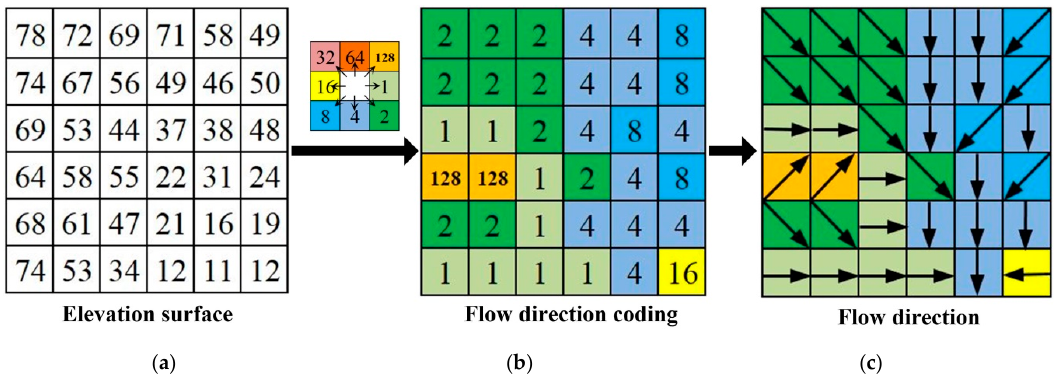
Figure 2. The process of obtaining flow direction. ( a ) elevation surface; ( b ) flow direction coding; ( c ) flow direction.